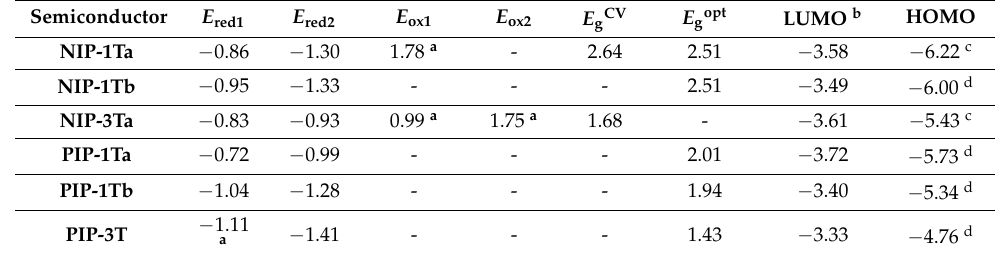
Table 6. Electrochemical potentials versus SCE in CH 2 Cl 2 (referenced to Fc/Fc + couple) of NIP-1T , NIP-3Ta , PIP-1T and PIP-3T and frontier molecular orbital energies estimated from CV data. Semiconductor E red1